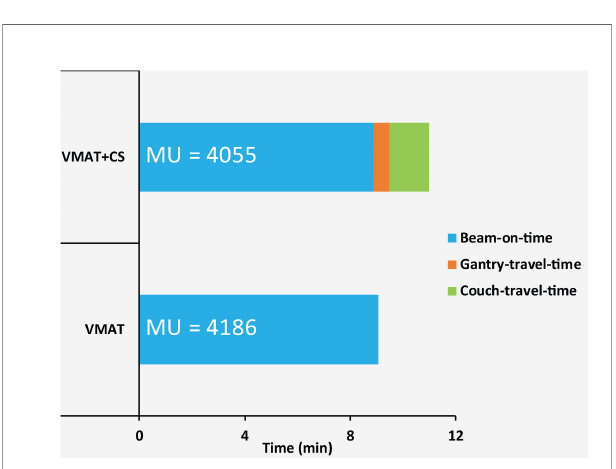
FIGURE 7 | Average measured beam-on-times, gantry-travel-times and couch-travel-times for fi ve VMAT and VMAT+CS plans. The numbers in the bars represent mean delivered